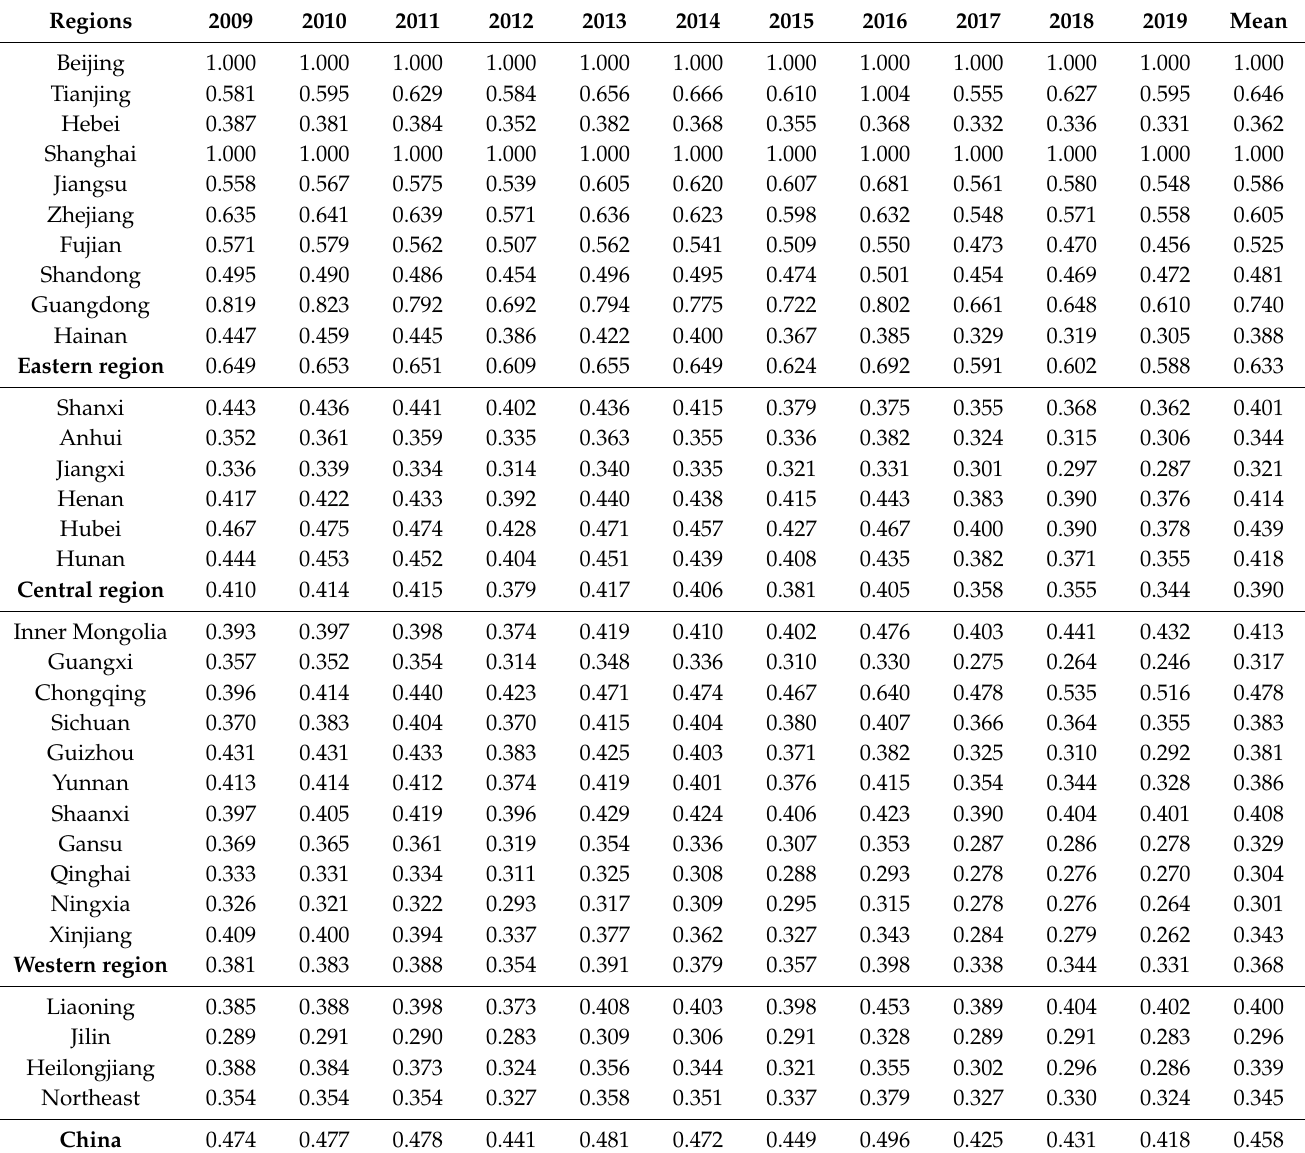
Table 5. The values of WRGUE for 30 provincial administrative units in China from 2009 to